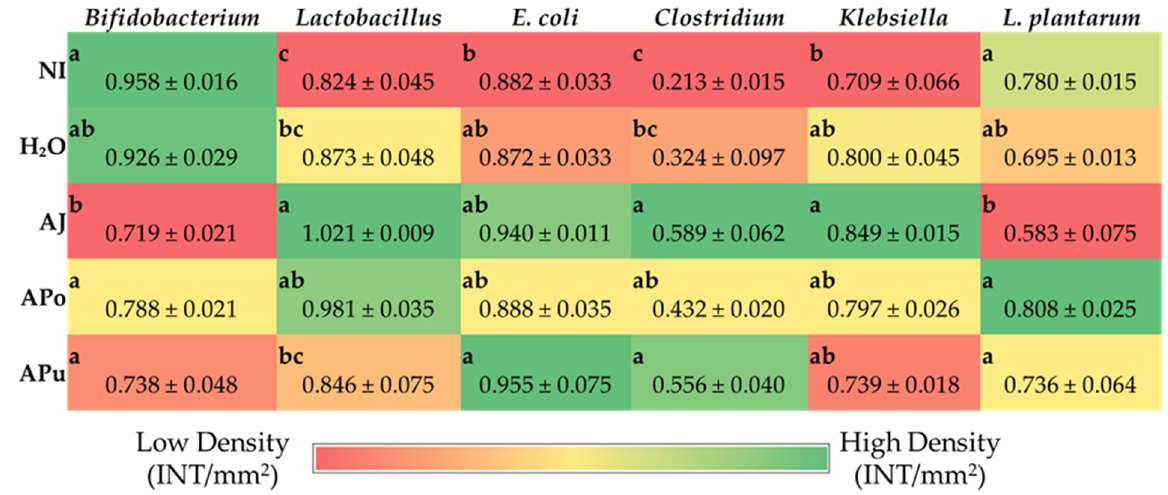
Figure 4. Effect of intra-amniotic administration of apple fraction soluble extracts on genera- and species-level bacterial populations from lower intestine contents on the day of hatch. Values are the means ± SEM, n = 5. a–c Treatment groups not indicated by the same letter in the same column are significantly different ( p < 0.05) by Duncan’s post-hoc test.